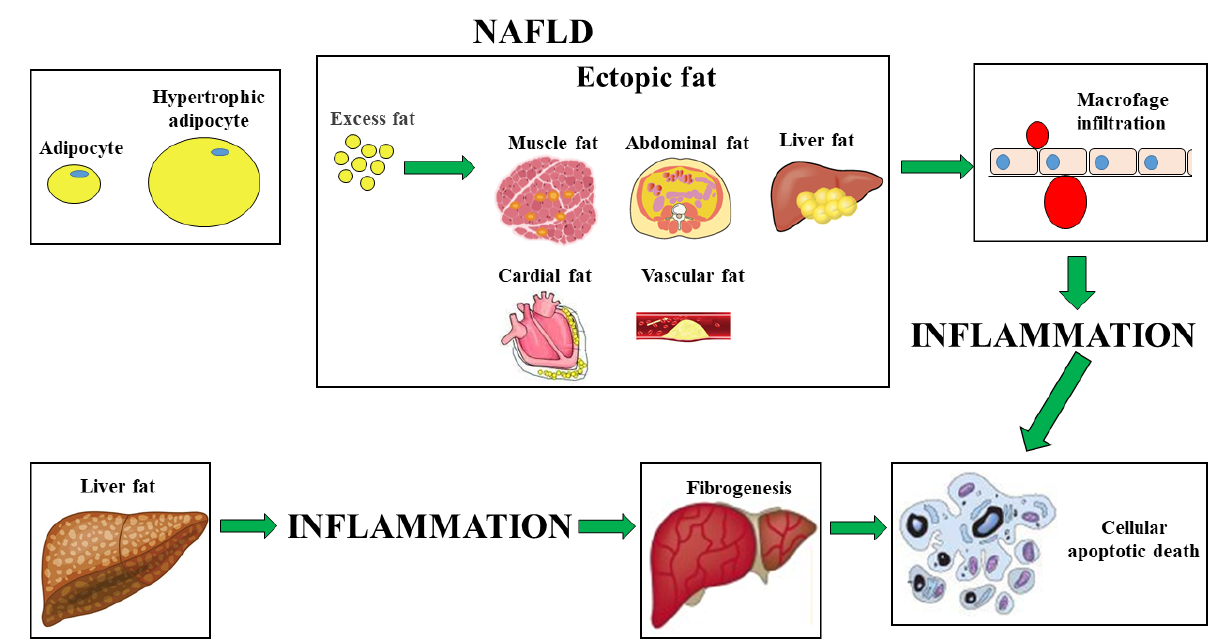
Figure 1. Representation of the evolution of NAFLD. The first box shows the hypertrophy of adipocyte that leads to an increase in cell size. The second box highlights the formation of ectopic fat, resulting from excessive fat gain, which involves other organs such as the liver, muscles, abdomen, heart and vascular system. The presence of ectopic fat promotes the infiltration of blood lymphocytes (the third box) and the onset of inflammation, responsible for apoptotic cell death (fourth box). Additionally, the fatty liver, if not treated, causes inflammation, which can evolve into fibrogenesis (second box from the left) and, in the final stage, into cellular apoptosis (third box from the left). Nutritional Interventions in